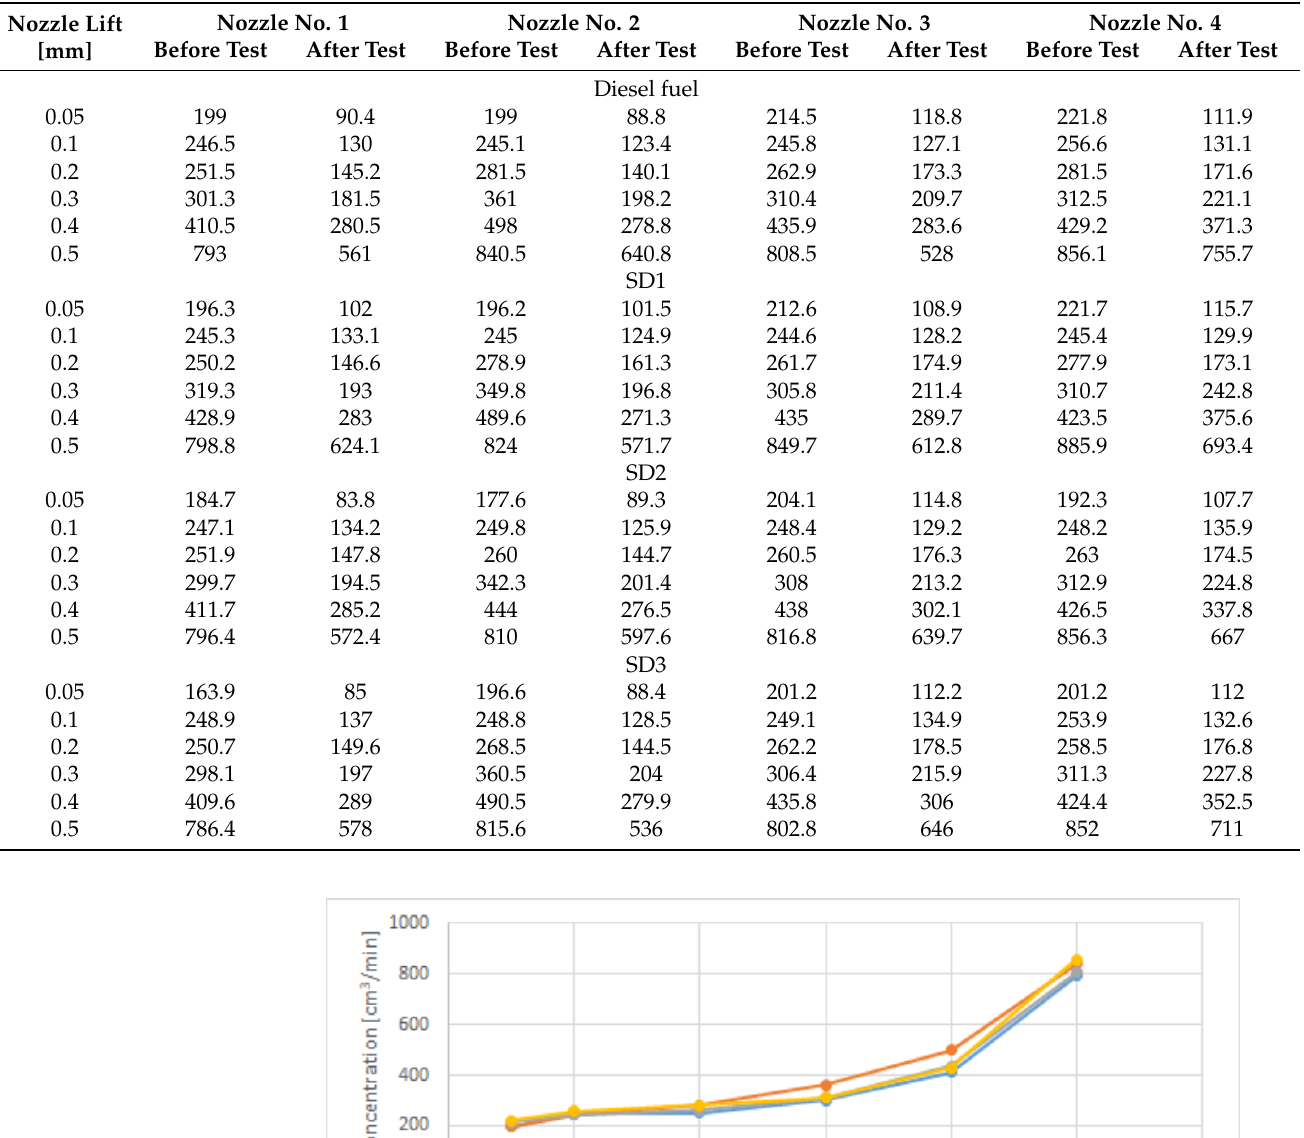
Table 4. Results of the research on the coking tendency of pintle injectors by the CEC F-23-01